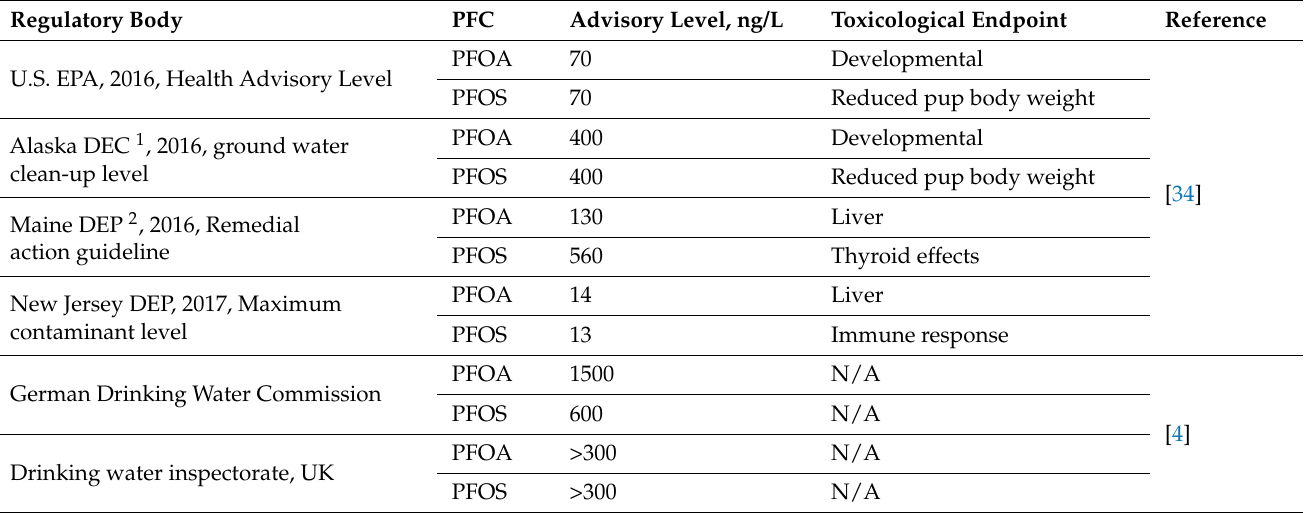
Table 2. PFOA and PFOS drinking water guideline